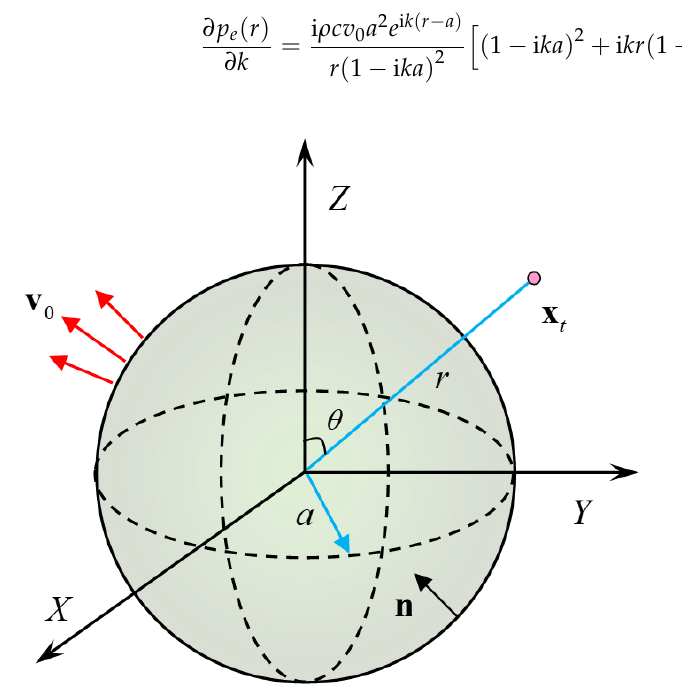
Figure 4. Acoustic radiation from a pulsating sphere.